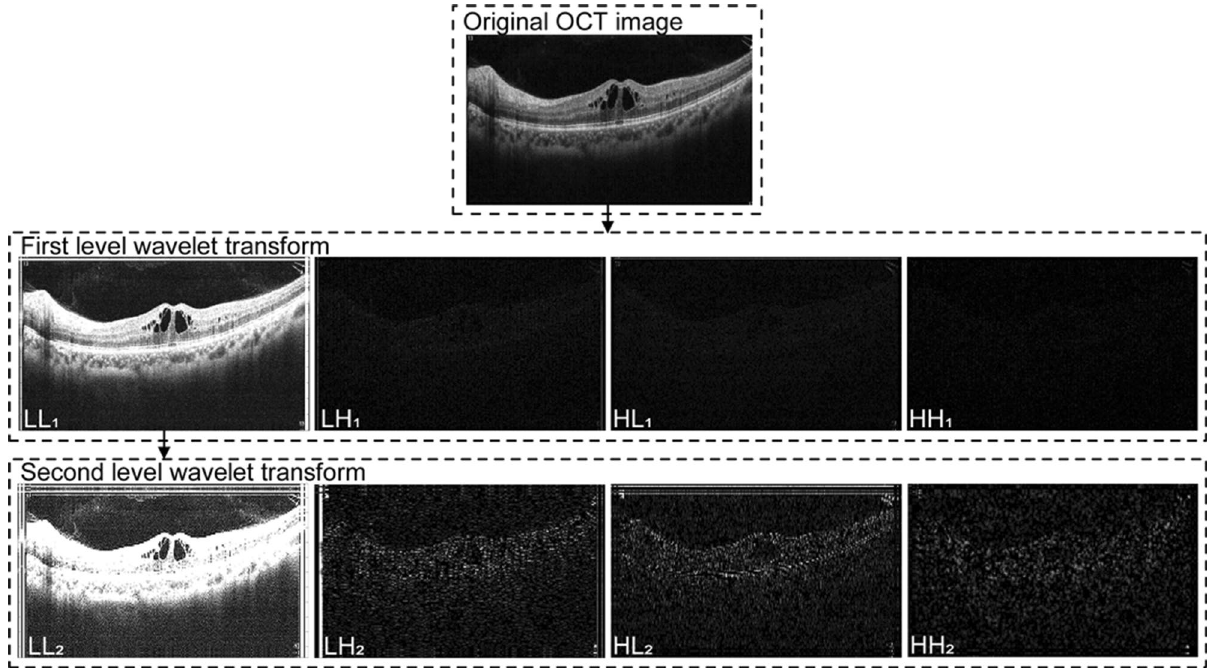
Figure 3. Decomposing process of OCT image by 2-level wavelet transform.